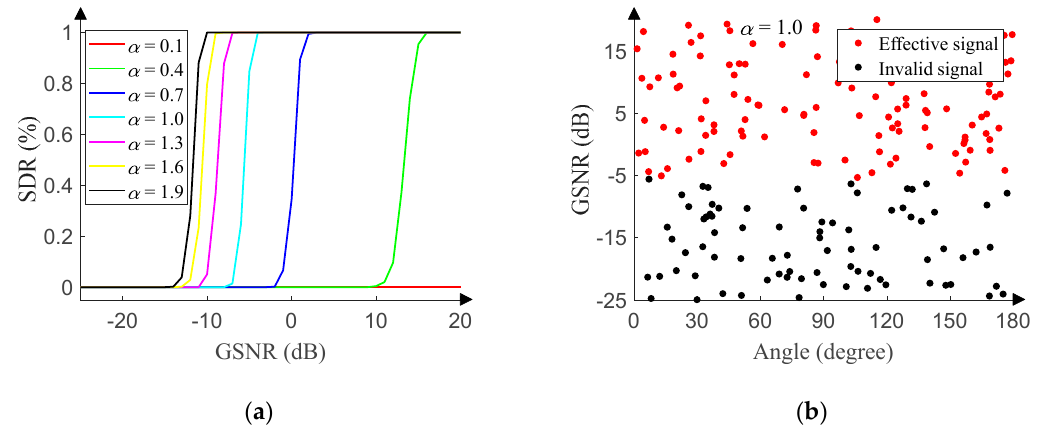
Figure 12. Signal monitoring network performance in non-Gaussian noise. ( a ) SDR versus GSNR. ( b ) Response of the signal monitoring network.